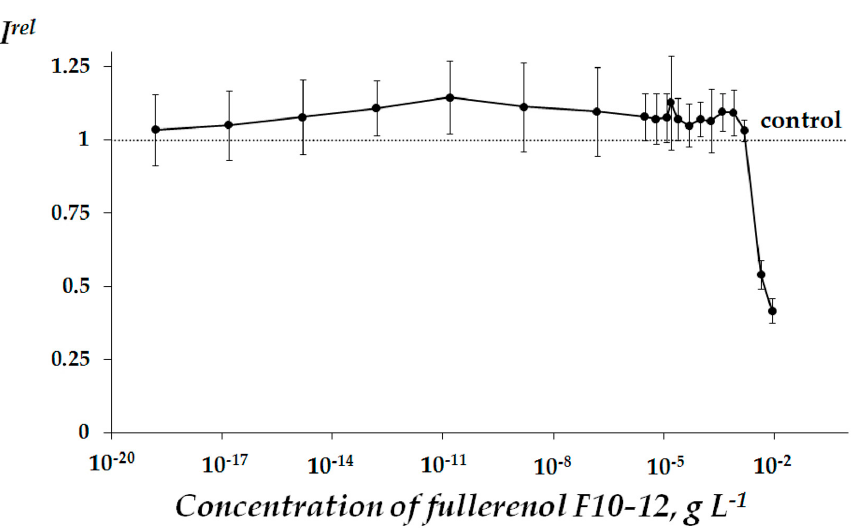
Figure 1. Bioluminescence intensity of enzymatic system, I rel , at different concentrations of fullerenol F10-12.